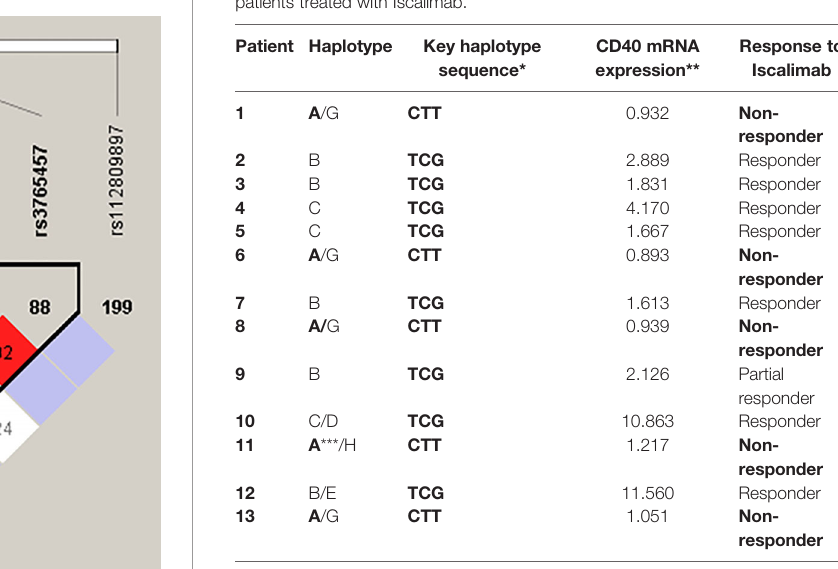
TABLE 4 | CD40 SNP haplotypes and mRNA expression levels in 13 GD patients treated with